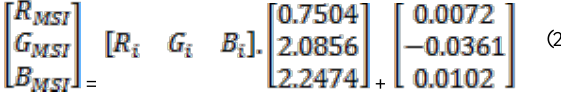
Figure 2. Calibration function generated by regression of the pre-processed Sentinel-2 MSI data set against reference spectra of the spill in RGB bands. Means of spill signatures from 7 location spill occurrences at a significance level, p < 0.001.